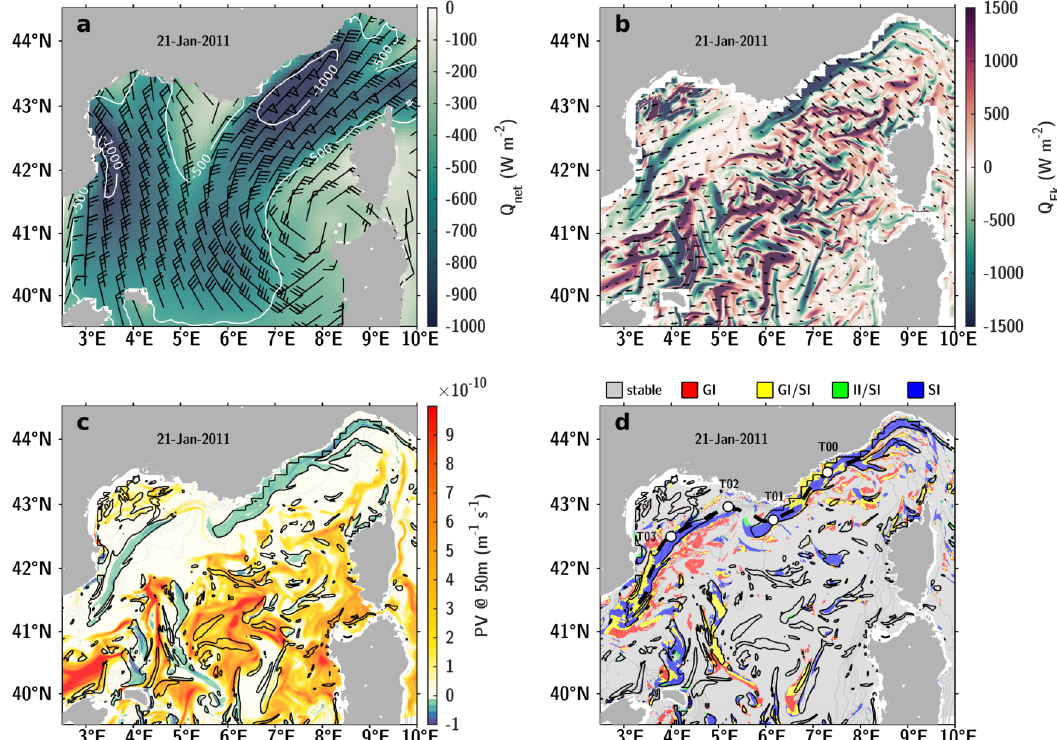
Figure 7. ( a ) Daily average net surface herat flux and winds from ALADIN re-analysis on 21 January 2011. ( b ) Ekman equivalent heat flux computed from the modeled surface buoyancy with black arrows proportional to Ekman transport. ( c ) Modeled geostrophic PV at 50m depth with black contours corresponding to Ekman equivalent heat flux exceeding 500Wm − 2 ( d ) Instability regimes at 50m following Thomas et al. [73]. The dashed line shows the mean NC path, defined as the zero vorticity contour computed from yearly mean currents, used to construct the Hovmöller diagram of Figure